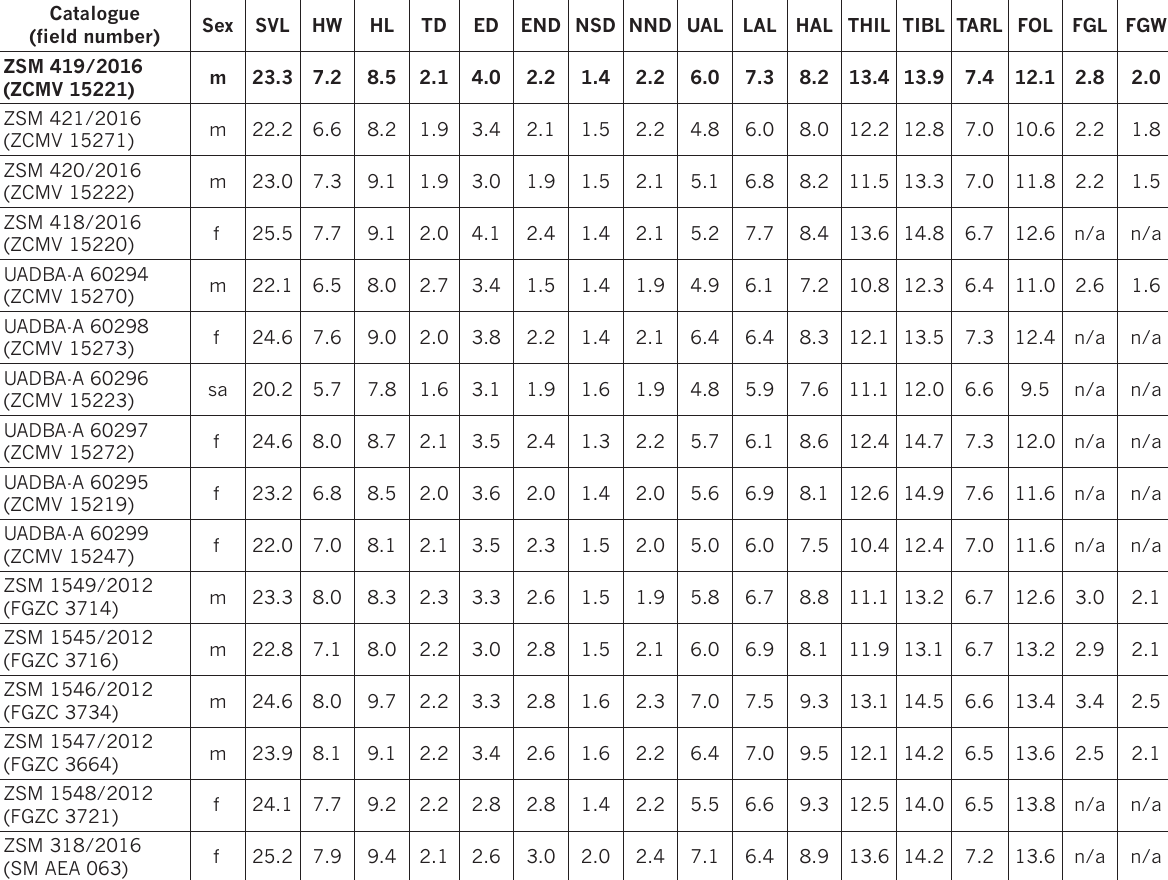
Table 1. Morphological data on specimens of Gephyromantis lomorina sp. n. Abbreviations: m = male, f = female, sa = subadult; for measurement abbreviations, see the Materials and methods. The holotype is bolded. Additive measurements (FARL, FORL, and HIL) are not explicitly shown but can be deduced from these